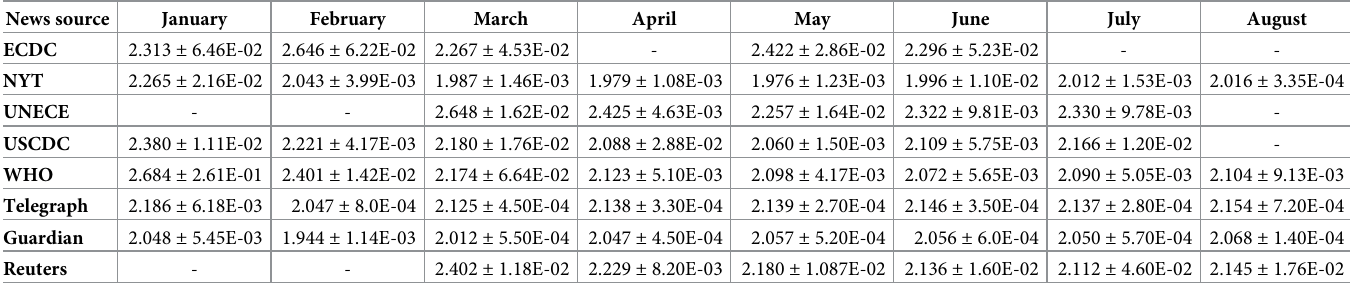
Table 4. Median monthly sentiment per news source and estimated 95% confidence intervals. Dashes denote lack of published articles during those